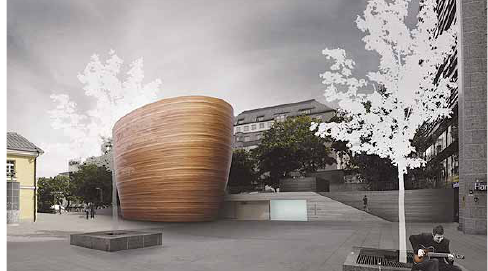
Fig. 17. Shopping center “SBA baldai”,